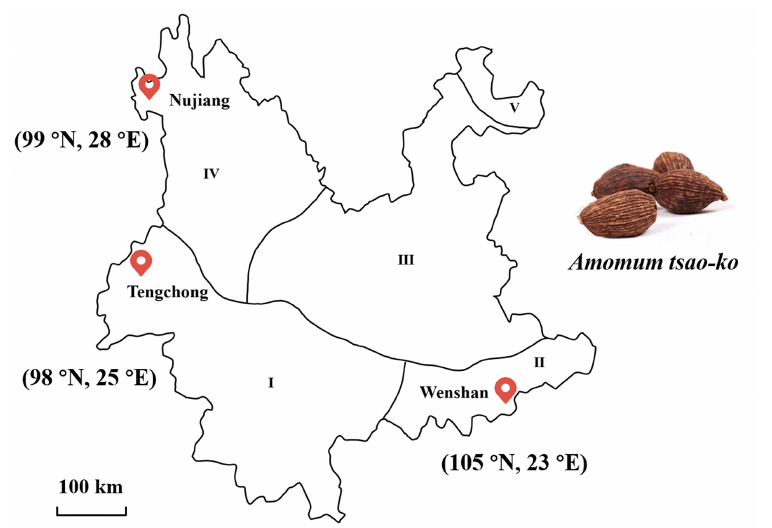
Figure 1. Floristic zoning map of Yunnan province and sampling sites of Amomun tsao-ko ( A. tsao-ko ). I (the south and southwest), II (the southeast), III (the middle plateau), IV (the west and northwest) and V (the northeast) represent different floristic zones of Yunnan province. The longitude and latitude of each region are labeled. A picture of A. tsao-ko (dried ripe fruit) is